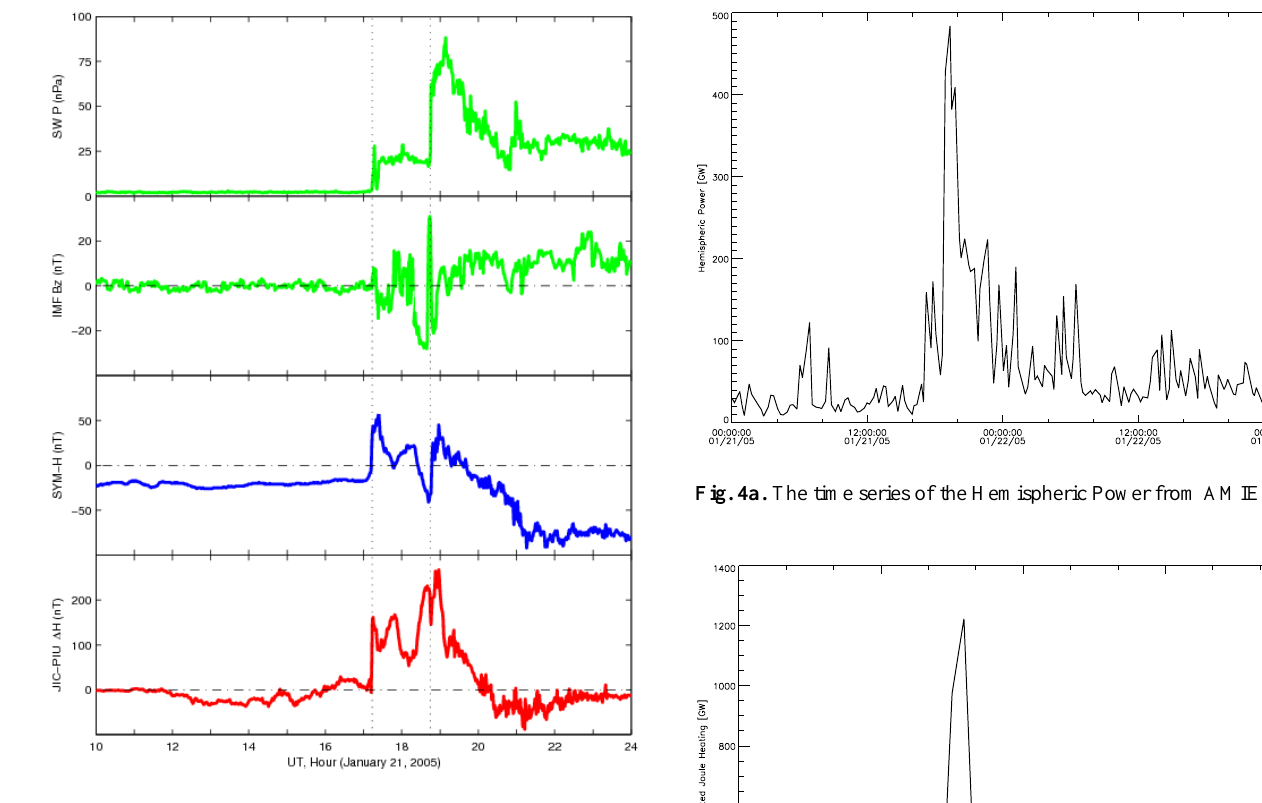
Fig. 3. Time variations of solar wind pressure (nPa), IMF B z (nT), sym-H (nT), and difference between northward magnetic fields at Jicamarca and Piura, Peru, during the period 10:00 to 24:00UT on 21 January 2005.